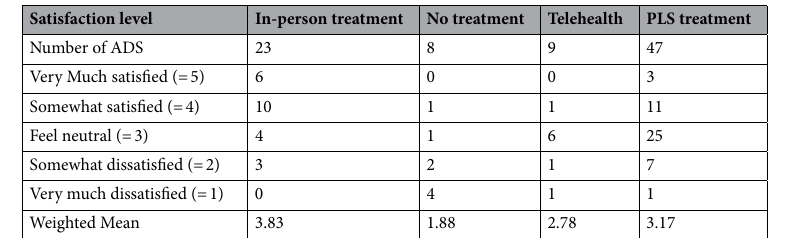
Table 2. Feeling of the cargivers about the treatment method and effictiveness.